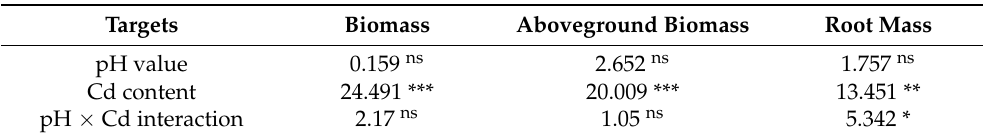
Table 2. Summary of the influence of each term (F-value) in a general linear model (GLM) test- ing the interacting influence of soil pH and cadmium (Cd) levels on biomass accumulation of Polygonum hydropiper .